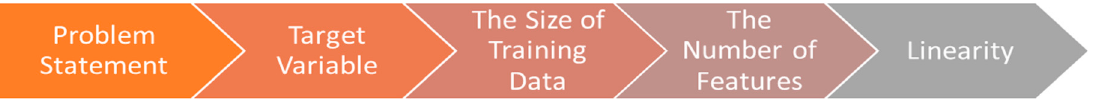
Figure 1. Some factors for selecting machine learning